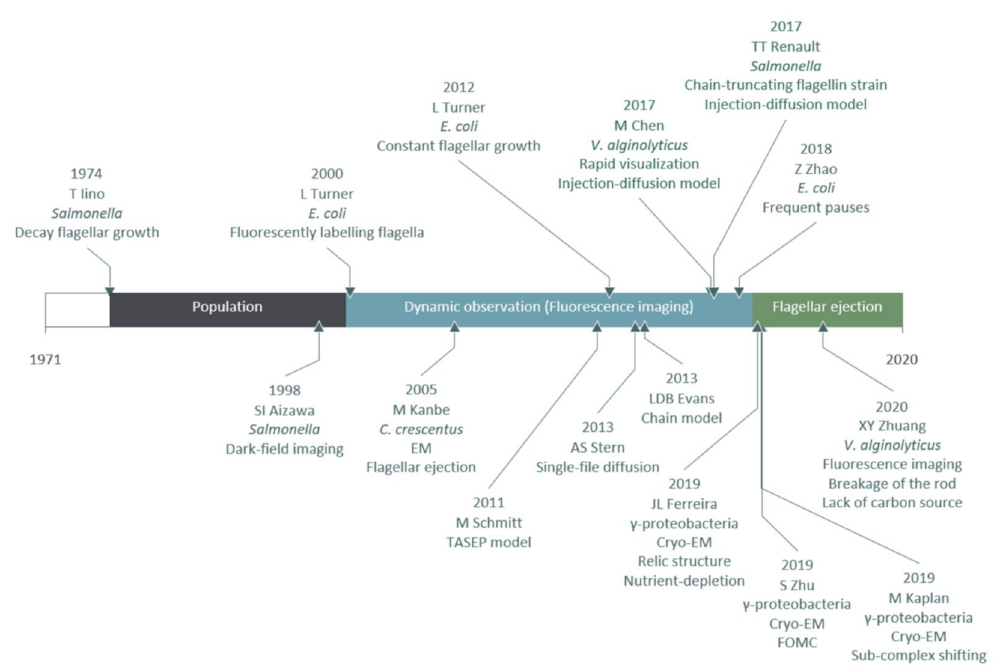
Figure 3. A timeline of experiments and models on flagellar filament construction and